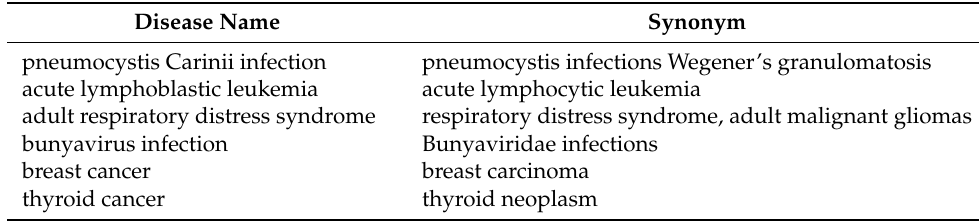
Table 4. Examples of disease synonyms.